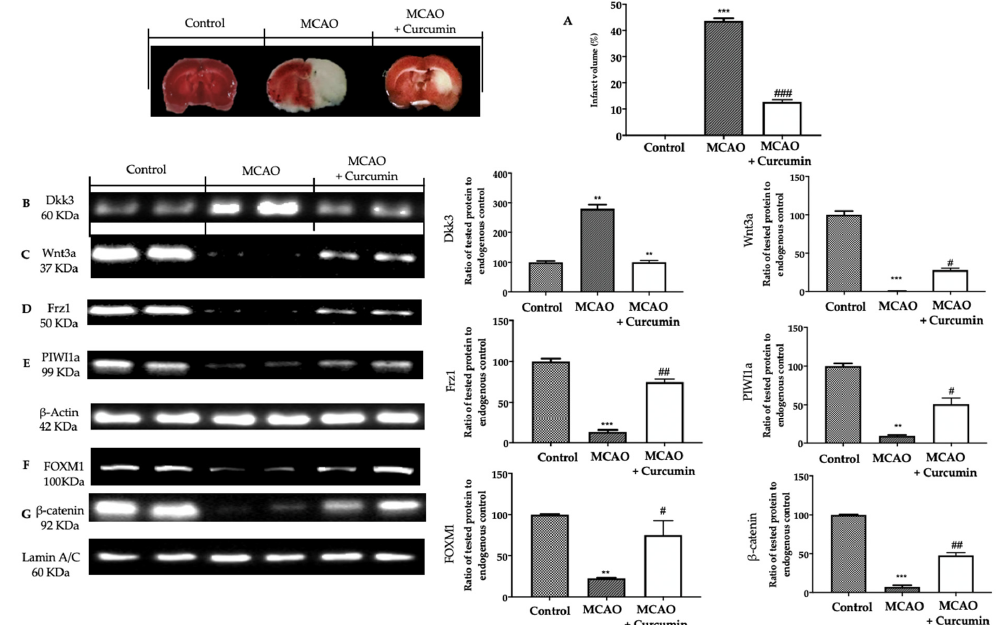
Figure 5. Analysis of Dkk3 in ischemic brain after curcumin administration: TCC analysis: ( A ) Infarct volume (%); Western blot analysis of ( B ) Dkk3, ( C ) Wnt3a, ( D ) Frz1, ( E ) PIWI1a, ( F ) FOXM1, ( G ) β‐ catenin. For these analyses, n = 5 animals for each group were employed. Data were analyzed by one ‐ way ANOVA followed by a Bonferroni post hoc test for multiple comparisons. A p ‐ value of less than 0.05 was considered significant: * p < 0.05 versus sham; ** p < 0.01 versus sham; *** p < 0.001 versus sham; # p < 0.05 versus MCAO; ## p < 0.01 versus MCAO; ### p < 0.001 versus MCAO.